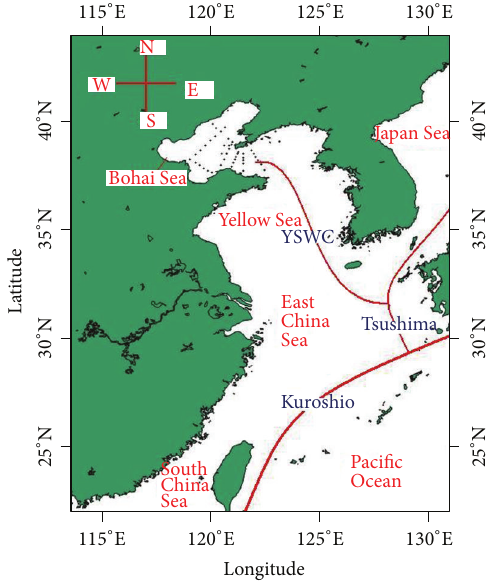
Figure 1: Study area (with symbol display area) sketch map.